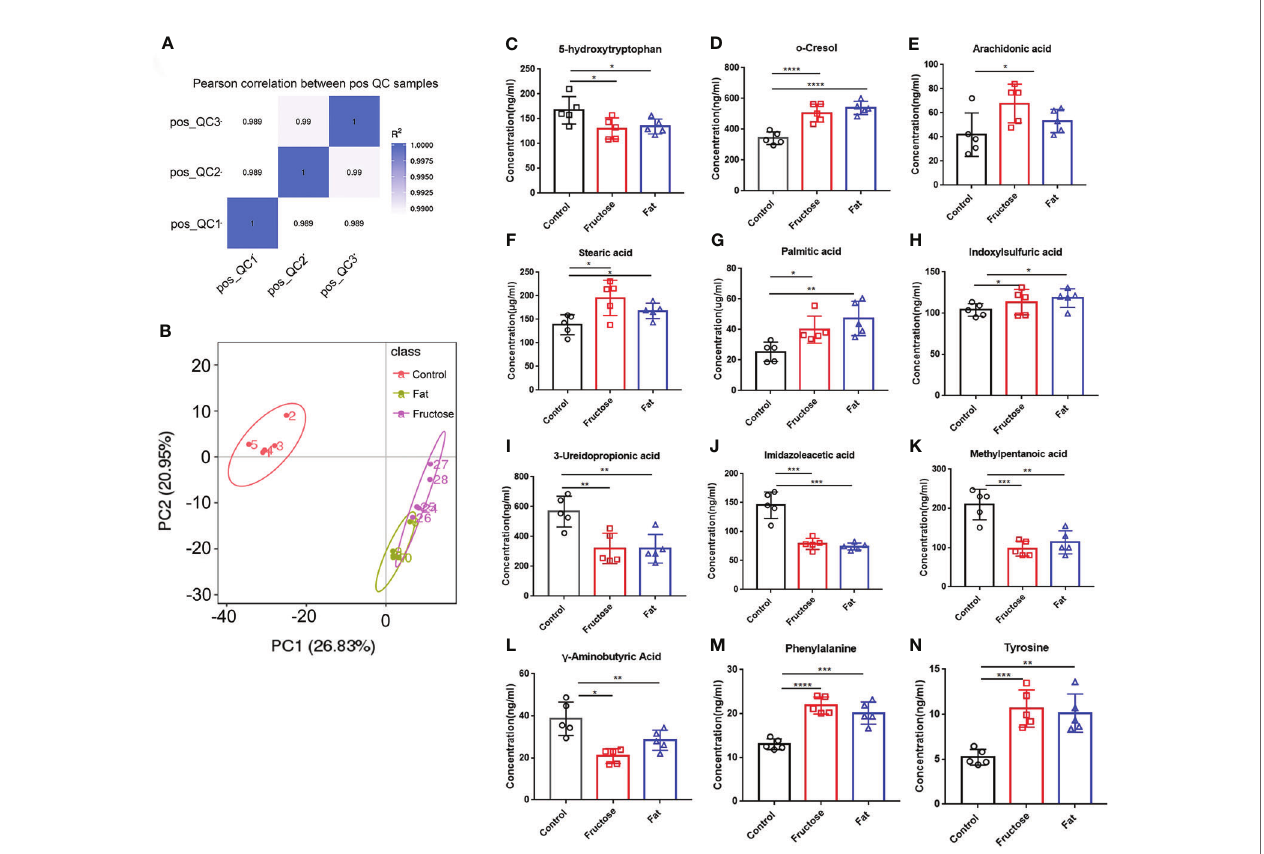
FIGURE 4 | The effect of high-fructose and high-fat diets on metabolites. The Pearson correlation coef fi cient between the quality control (QC) samples was calculated based on the peak area value (A) . In the PCoA analysis, the abscissa PC1 represents the fi rst principal component score, and the scattering of different colors represent the samples of the different experimental groups. The closer the distance is, the smaller the difference between the samples is, and the ellipse is the 95% con fi dence interval (B) . The contents of o-cresol (C) , arachidonic acid (D) , stearic acid (E) , palmitic acid (F) and indole sulfuric acid (G) in fecal metabolites were determined. The